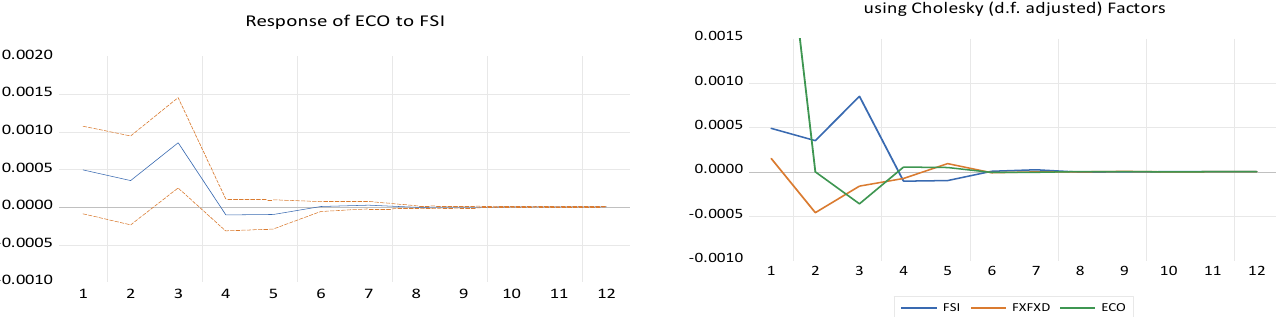
Figure 3. Response of output to FSI and FXFXD shocks. Figure 4. Combine impulse response functions of FSI and FXFXD to innovation. Variance Decompositions of Variables -4-20 24